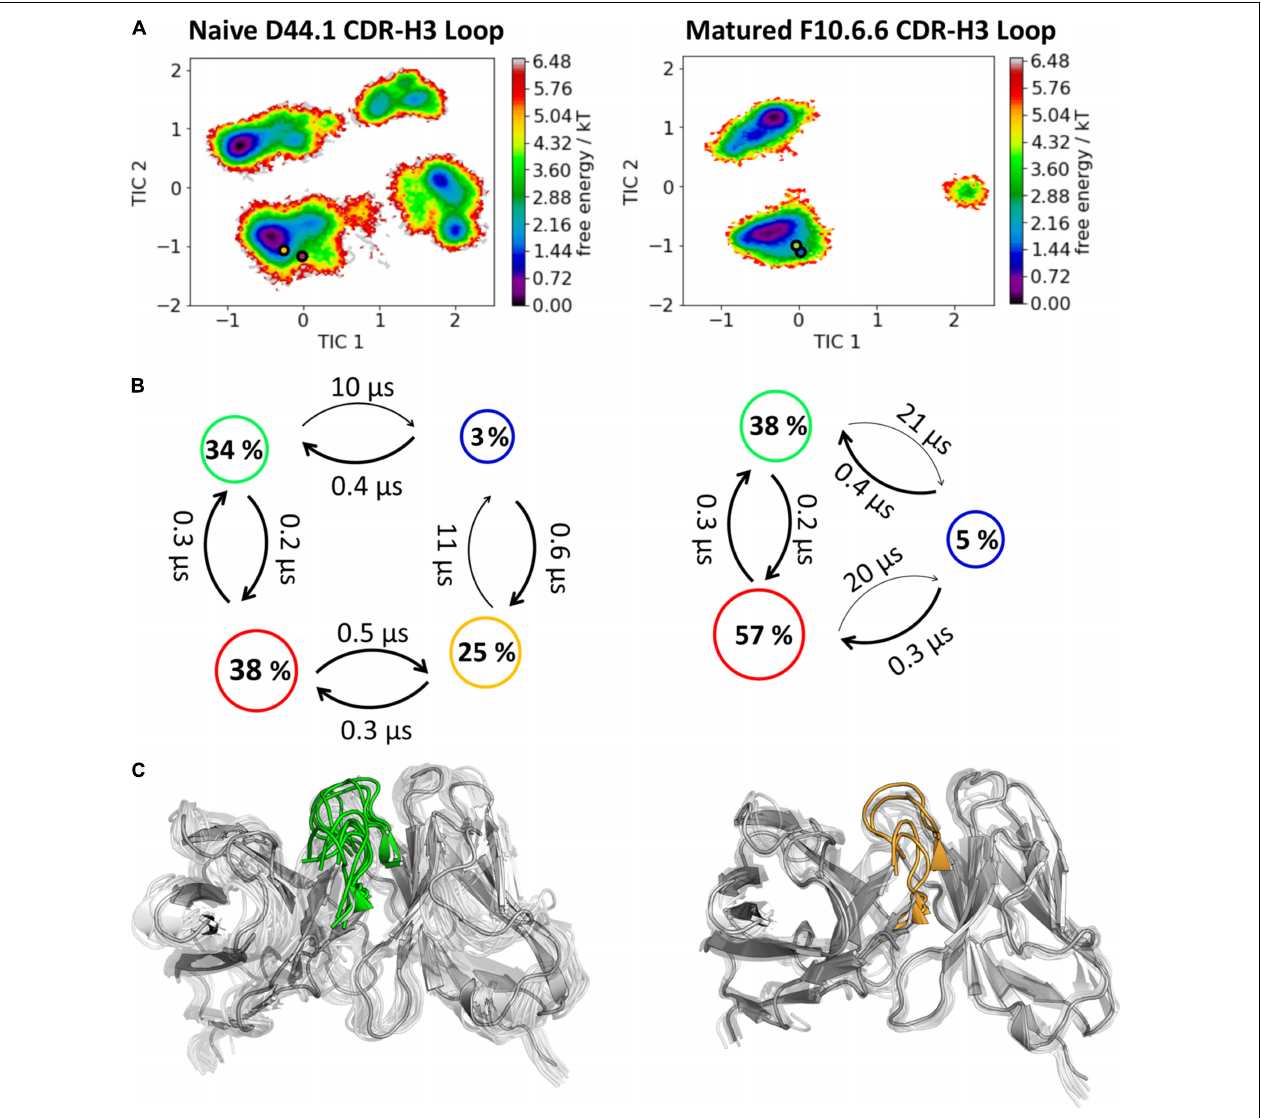
FIGURE 2 | Kinetic, thermodynamic and structural analyses of the CDR-H3 loop ensemble in solution. (A) Free energy surface of the naive D44.1 and the matured F10.6.6 Fab in the same coordinate system, including the respective X-ray structures crystallized with and without antigen. The orange and green dots show the bound X-ray structures of the naïve and the matured Fab, respectively, while magenta and blue display the X-ray structures crystallized without antigen. (B) Transition timescales between the different macrostates orientated according to the tICA space including the state probabilities. (C) Substantial decrease of the conformational ensemble of the D44.1 and F10.6.6 antibody upon affinity